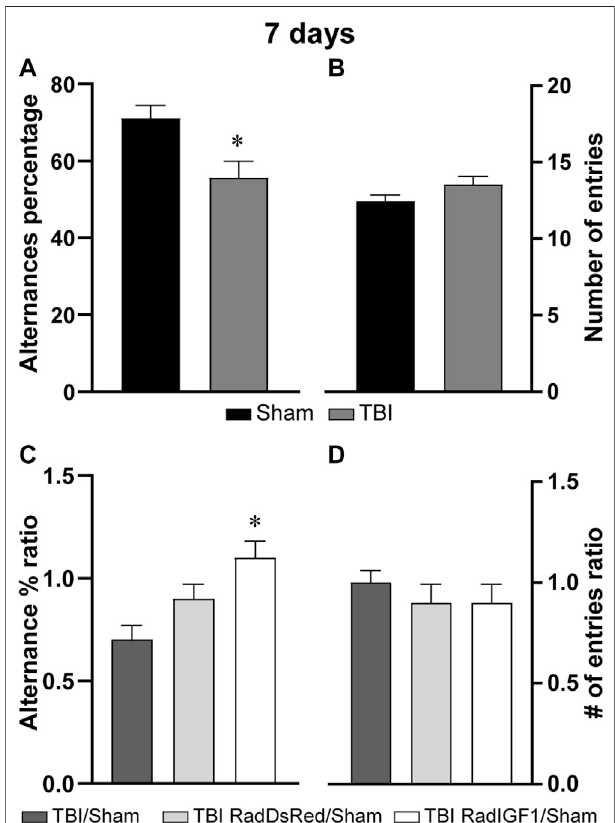
FIGURE 5 | Early IGF-1 treatment prevented TBI-induced working memory de fi cit observed 7 days after injury. The graphs show working memory performance assessed by the Y-maze paradigm. Graphs (A) and (B) show the percentage of spontaneous alternations and percentage of spontaneous alternations in a Y-maze arena, respectively, in Sham and TBI groups. Graphs (C) and (D) represent the percentage of spontaneous alternations or number of entries ratio respectively, between TBI or TBI + treatmentgroupsandShamgroup(TBI/Sham,TBIRadDsRed/Sham,andTBI RadIGF1/Sham). Bars represent the mean ± SEM, n (cid:2) 10 – 11. *Different from TBI/Sham ( p (cid:2) 0,0095).